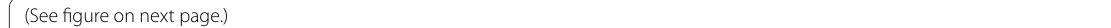
figure on next Fig. 3 Local solar time versus quasi-dipole (QD) latitude depiction of the Sq field ( a ) and L field at the new Moon ( b ), as derived from quiet-time data from Swarm A in the magnetic northward ( N ), magnetic eastward ( E ) and center ( C ) components during 2017–2020. In each of a and b the upper panels show the observed Sq or L field, while the lower panels show the Sq or L field reconstructed by a magnetic scalar potential described by (4)–(6). Contour steps are 2 nT for Sq and 0.4 nT for L. It is noted that local lunar time equals local solar time at the new